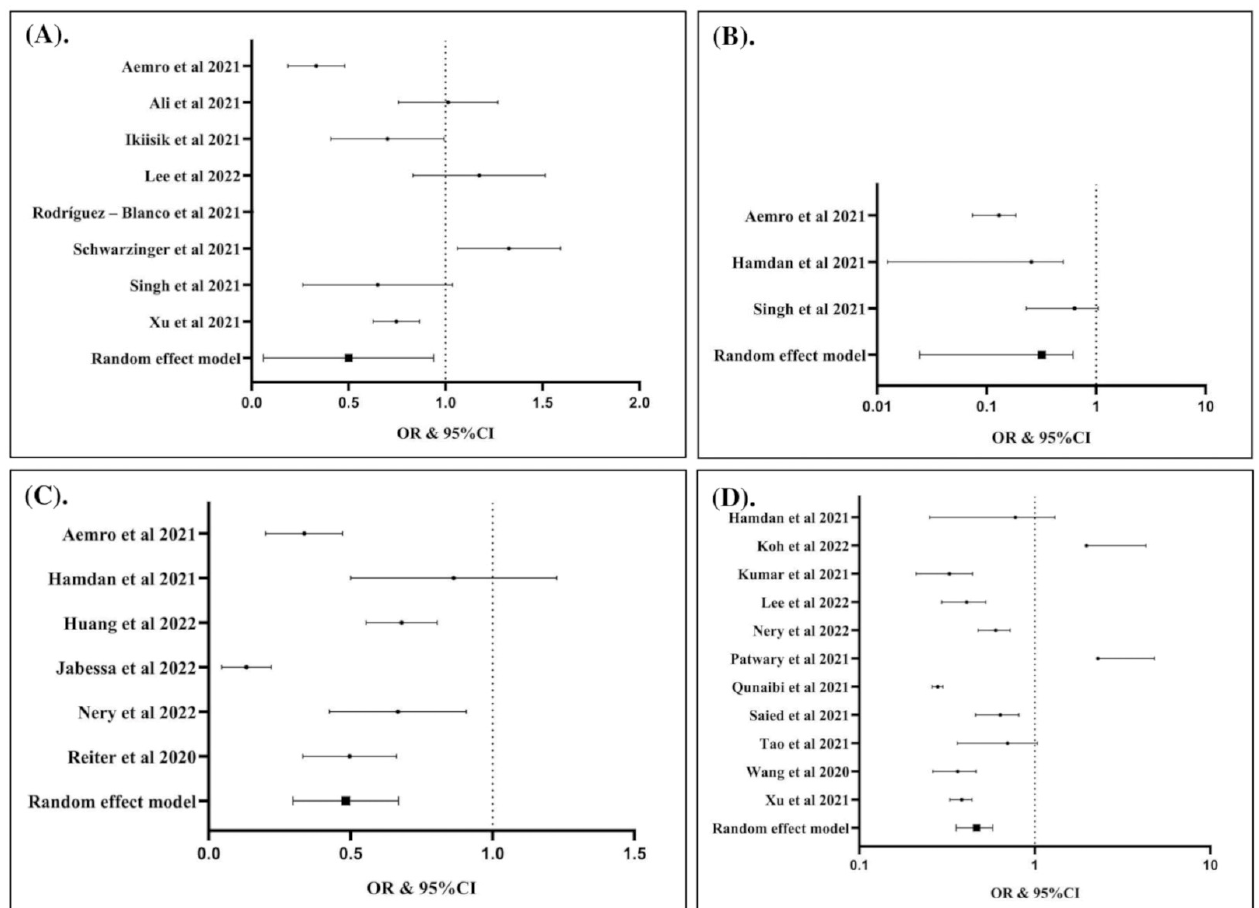
Figure 6. Individuals living with children in the home had lower risk of hesitancy to COVID-19 vaccination (OR: 0.37; 95% CI: 0.14, 0.99; p Egger: 1.4040; p heterogeneity: <0.0001; p : 0.0490) ( A ); individuals keeping physical distancing had lower risk of hesitancy to COVID-19 vaccination (OR: 0.23; 95% CI: 0.08, 0.65; p Egger: 0.8370; p heterogeneity: 0.0010; p : 0.0050 ( B ); individuals with history of COVID-19 test were associated with lower risk of hesitancy to COVID-19 vaccination (OR: 0.46; 95% CI: 0.31, 0.68; p Egger: 0.4340; p heterogeneity: <0.0001; p : <0.0001) ( C ); individuals with history of influenza vaccination in the past few years had lower risk of hesitancy to COVID-19 vaccination (OR: 0.46; 95% CI: 0.36, 0.58; p Egger: 0.3460; p heterogeneity: <0.0001; p : <0.0001) ( D ). The studies included are provided in the reference list [19,25–79].